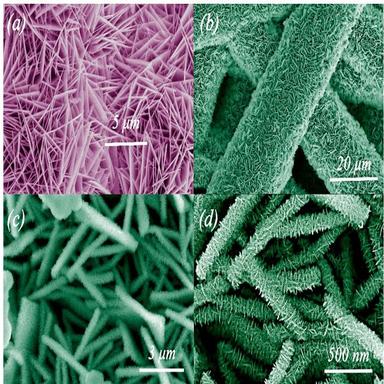
(a) SEM image of ZnCo2O4/CP; (b), (c) ZnCo2O4@NiMoO4/CP SEM images of different magnification; (d) at high magnification SEM image of ZnCo2O4@NiMoO4/CP.